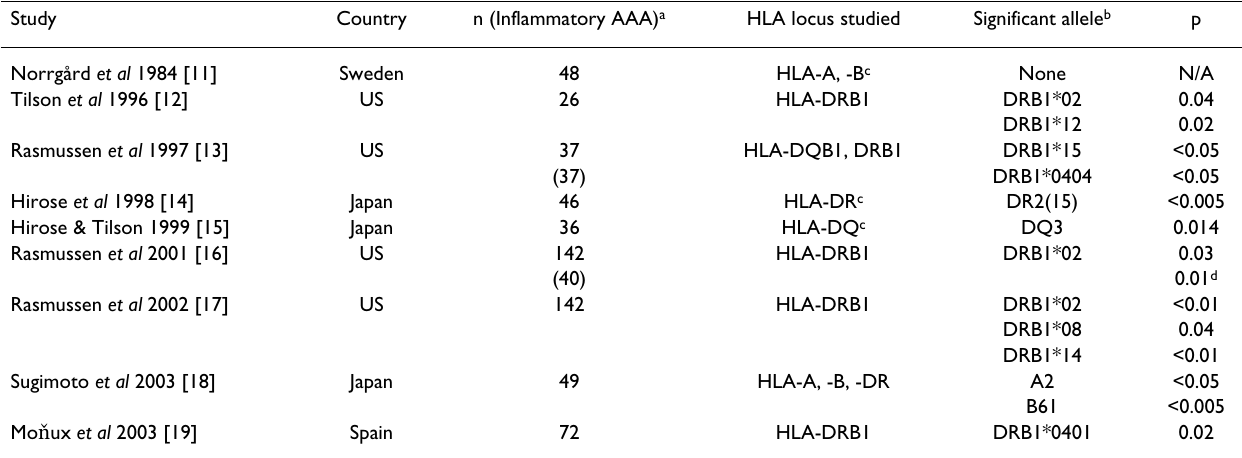
Table 9: Previous HLA studies on